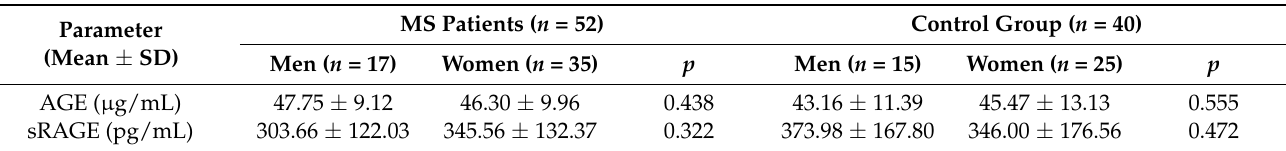
Table 2. Serum AGEs and sRAGE concentrations in MS patients and healthy controls depending on the gender (Mann–Whitney U test).